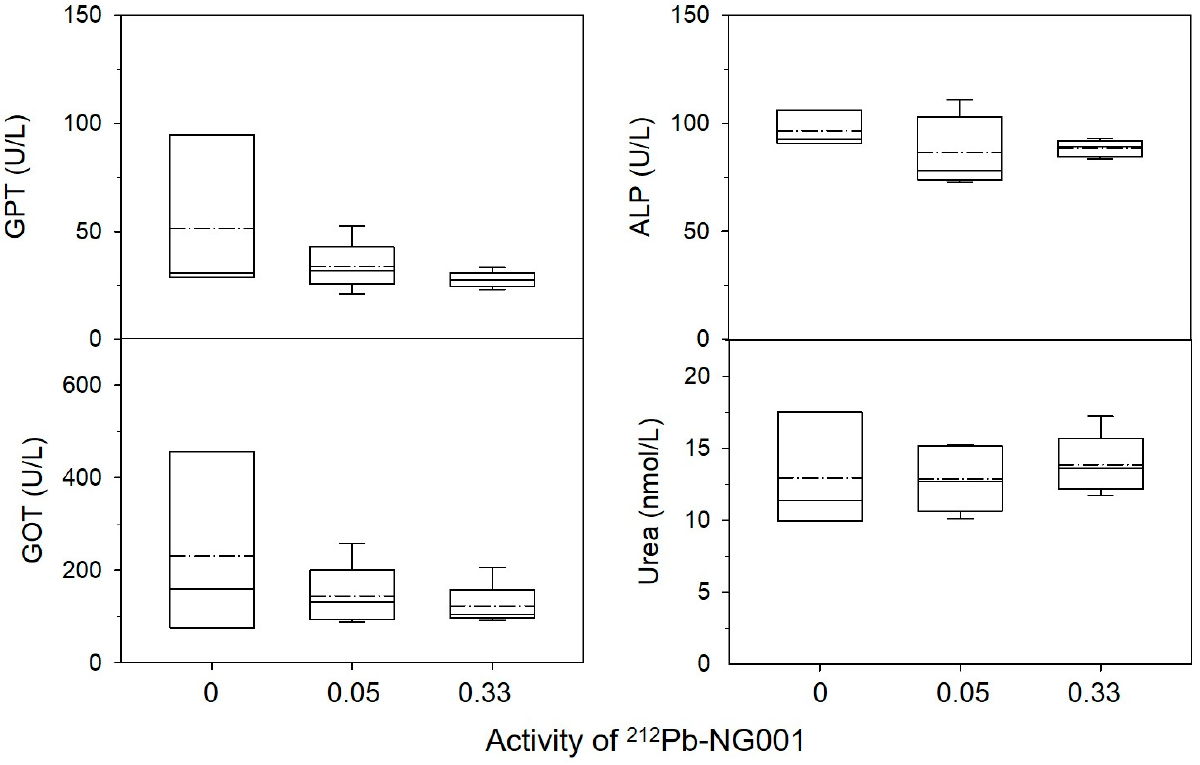
Figure 7. Blood chemistry in BALB/c mice treated with saline (N = 3), 0.05 MBq (N = 5) or 0.33 MBq (N = 5) of 212 Pb-NG001. Confirmed normal values of bilirubin <8.55 µmol/L and creatinine <44.2 µmol/L were measured for all mice (results not shown). Bottom of the boxes represent the 25th percentile, dashed lines represent mean, solid lines represent median, top of the boxes represent the 75th percentile and whiskers represent the 5th and 95th percentiles. GOT, glutamic oxaloacetic transaminase; GPT, glutamic pyruvic transaminase; ALP, alkaline phosphatase.